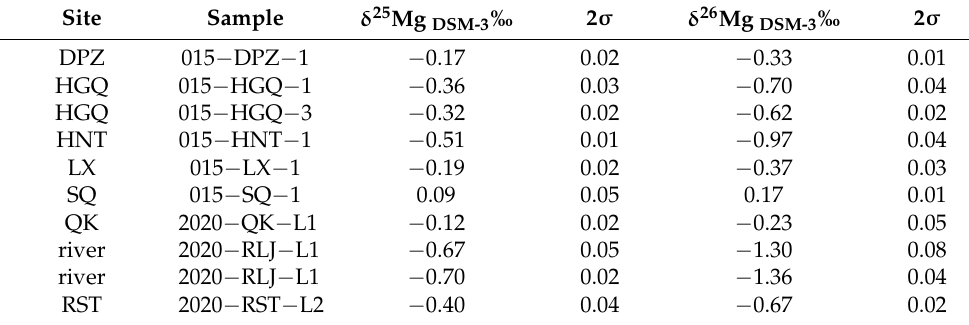
Table 2. The Mg isotopic compositions of the Tengchong hydrothermal fluids.